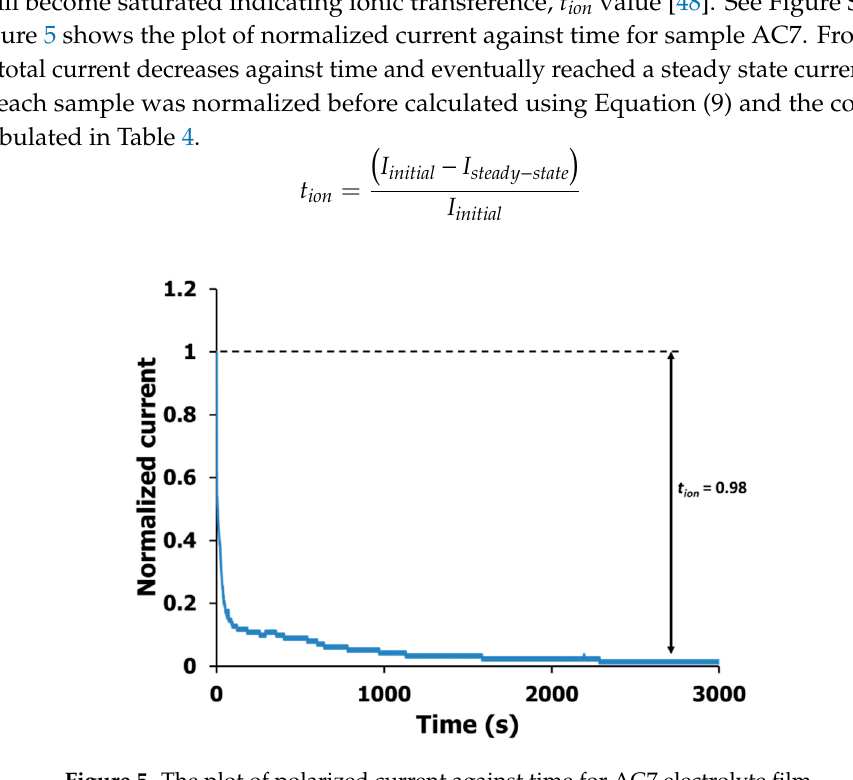
Figure 5. The plot of polarized current against time for AC7 electrolyte film.